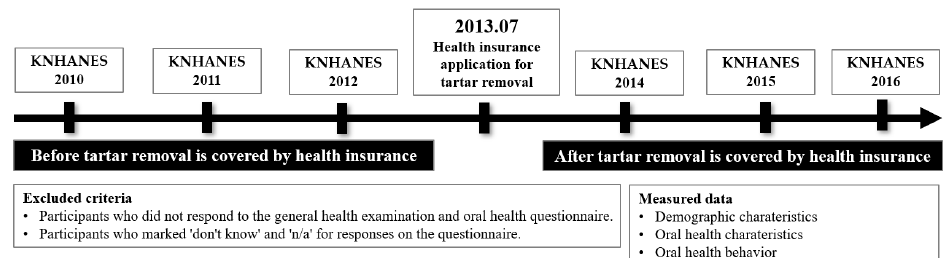
Figure 1. Study design.